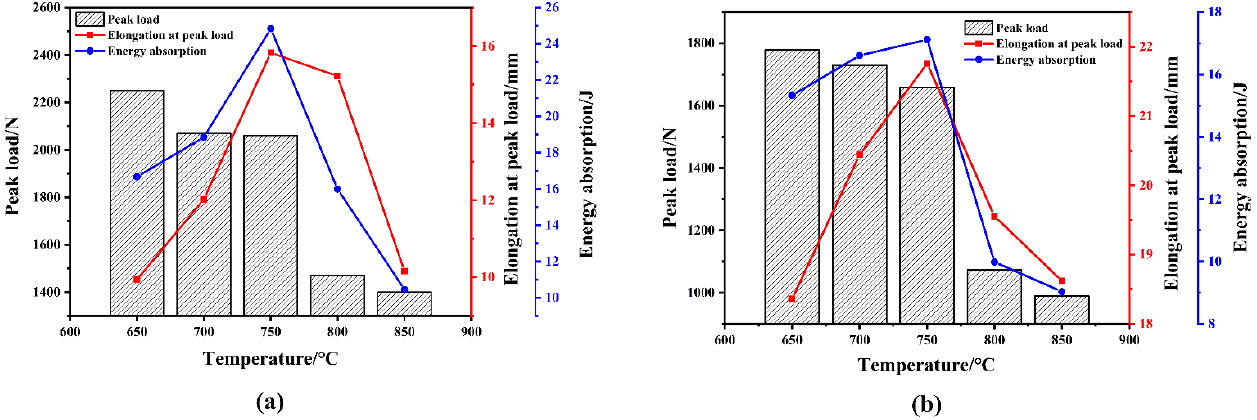
Figure 10. Effect of temperature on peak load, elongation at peak load, and energy absorption: ( a ) tensile shear test; ( b ) cross-tension test.